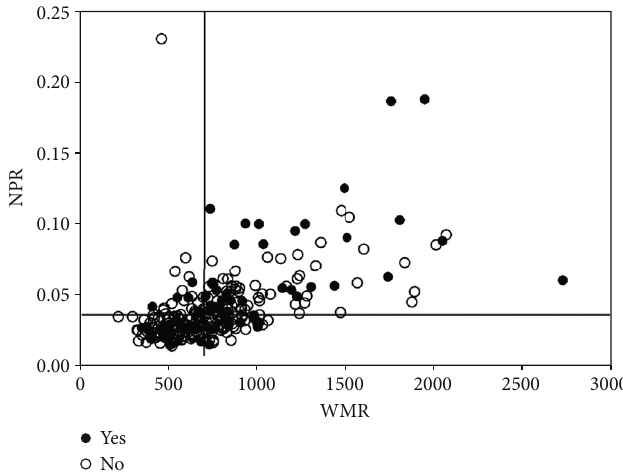
Figure 2: Scatterplot between WMR and NPR. WMR and NPR had a signi fi cant correlation (Spearman r = 0 : 613 , P < 0 : 001 ). When WMR cut-o ff value of 701 and NPR cut-o ff value of 0.03 were used, 34% of MACE occurred in high WMR and high NPR group (right upper quadrant). WMR: white blood cell count to mean platelet volume ratio; NPR: neutrophil-to-platelet ratio; MACE: major adverse cardiovascular